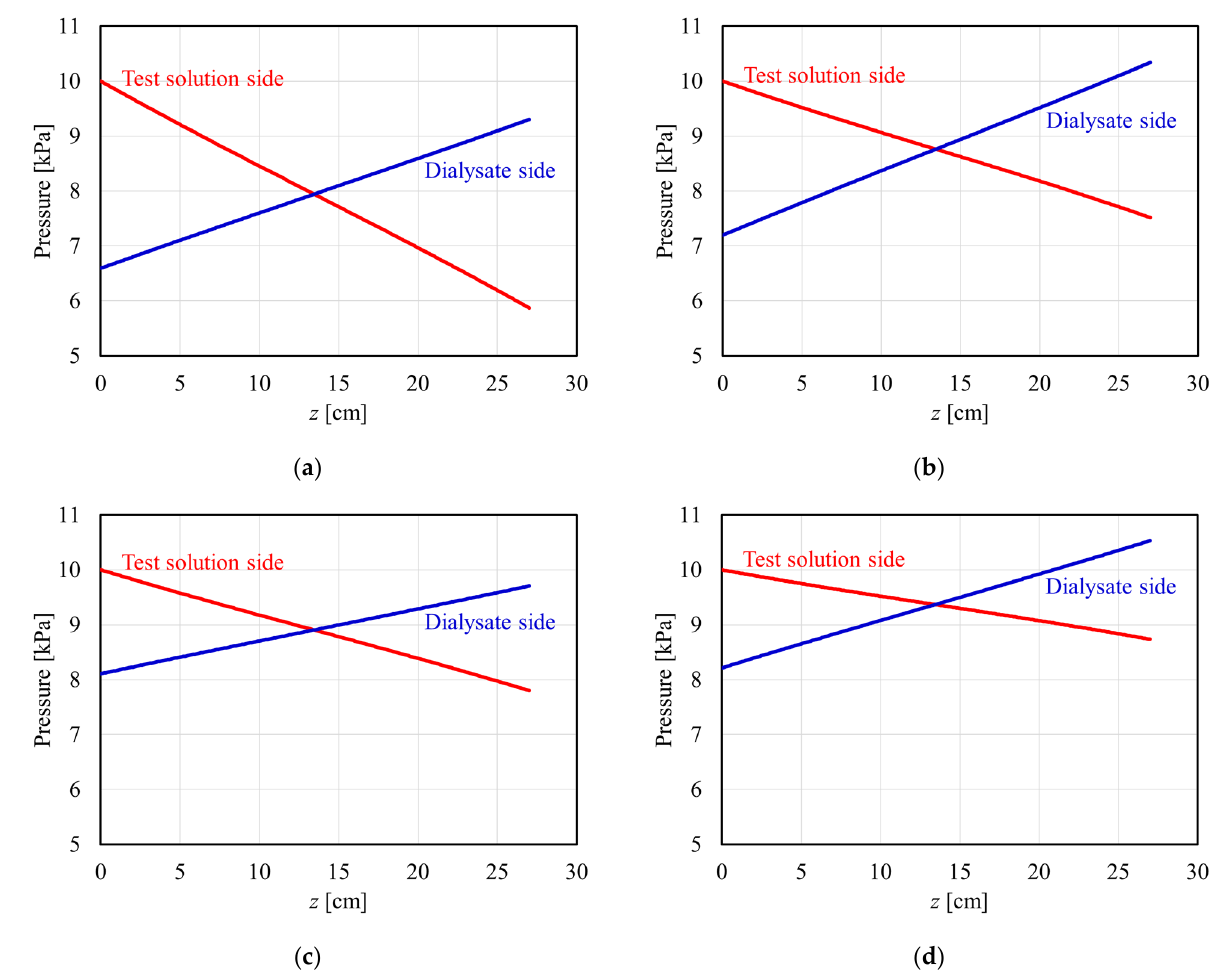
Figure 5. Pressure distribution in APS-SA series with a membrane surface area of ( a ) 8000 cm 2 , ( b ) 13,000 cm 2 , ( c ) 15,000 cm 2 , and ( d ) 25,000 cm 2 .